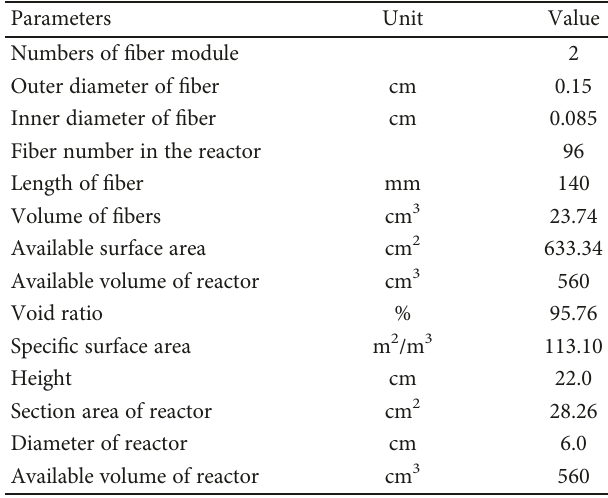
Figure 1: MBfR in the experiment (a) and theoretical views of MBfR (b). Table 1: The parameters of the